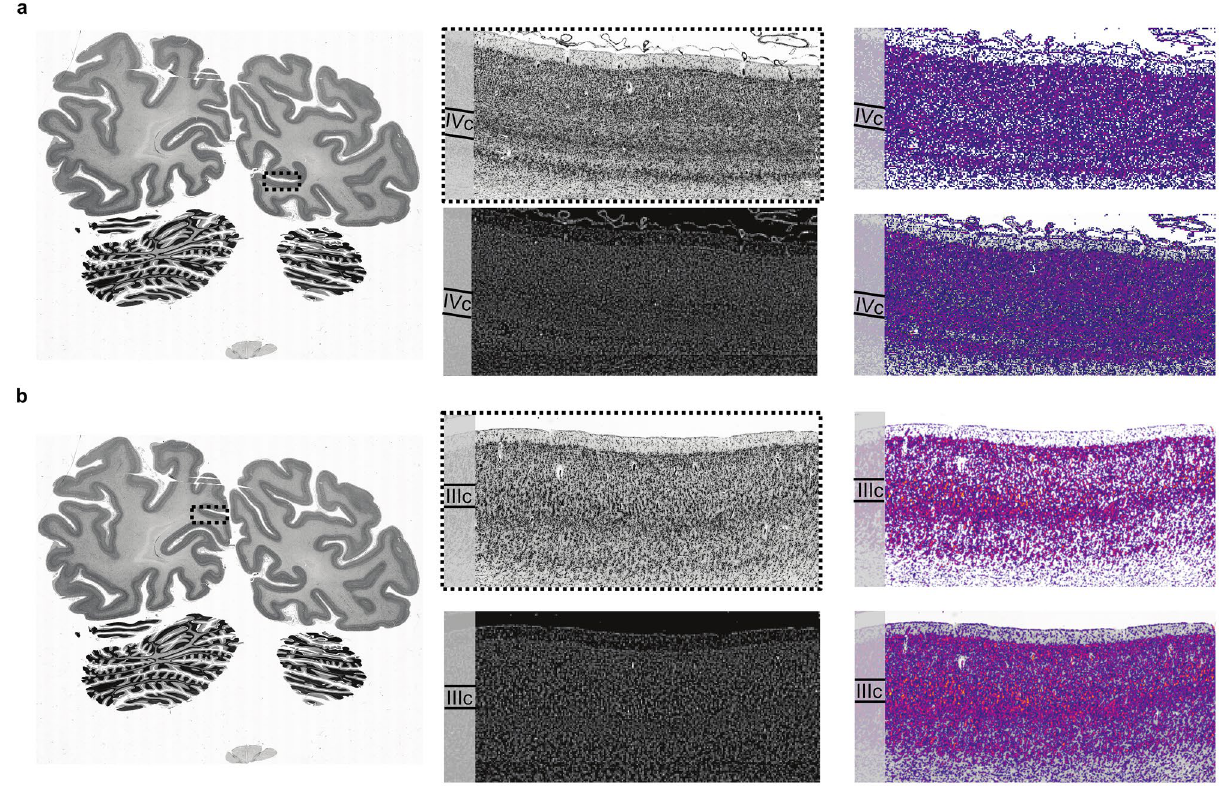
Figure 5. First level filter activations from network layer four of the hOc1 ( a ) and network layer one of the hOc2 CNN ( b ). The images on the left show the region of interest on the validation section (section 1021). The four images in the middle and right show microscopically magnified regions of interest of cortical area hOc1 ( a ) and hOc2 ( b ) depicted by dashed lines on the section on the left. In the middle, magnified histological cell-body stained images of the regions are displayed over the corresponding GLI images. Images on the right show the magnified characteristic filter activations (upper images) superimposed on cell-body stained images (lower images). Cortical sublayers with notable first level cytoarchitectonic features that are visible in the filter activations and the GLI images are marked by roman